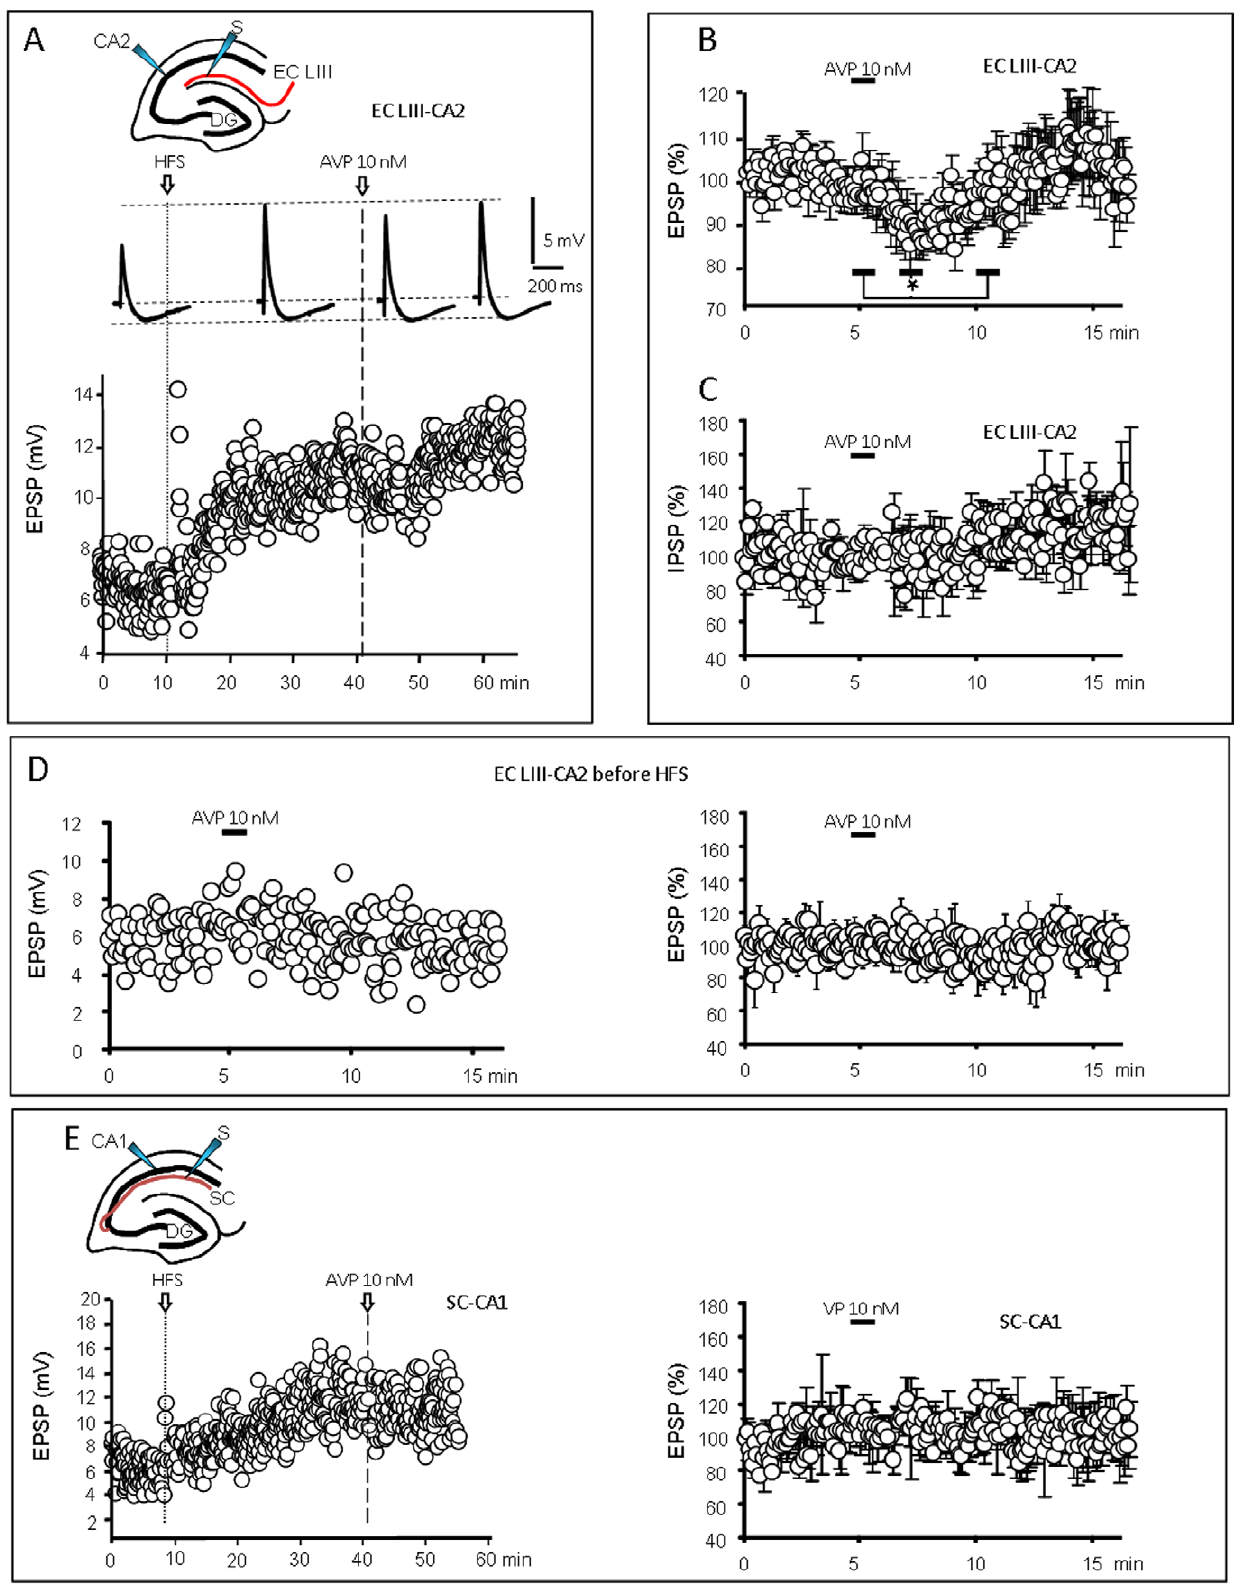
Figure 2. Vasopressin decreases EPSPs in CA2 after LTP induction. A: Top: typical recordings of the combined EPSP/IPSP evoked by stimulation of LIII entorhinal fibers (EC LIII) and recorded in CA2 pyramidal neurons (inset). Traces are averages of 12 successive responses recorded during 1 min, before high frequency stimulation (HFS) and during LTP before, during and after the response to AVP (10 nM ; 1 min). Bottom graph: